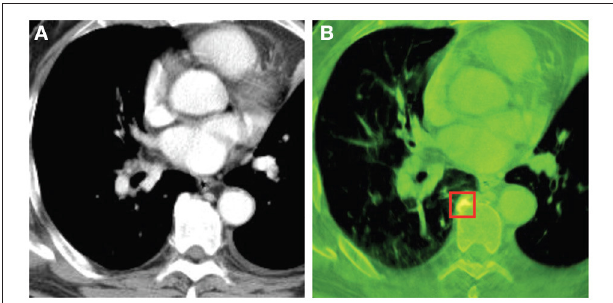
FIGURE 5 | Chest images with the display window [ − 532, 166] (Unit: HU). From left, (A) image reconstructed by Shinva XHCT-16; (B) synthesized color image with components at 40 keV, 50 keV, and 100 keV.